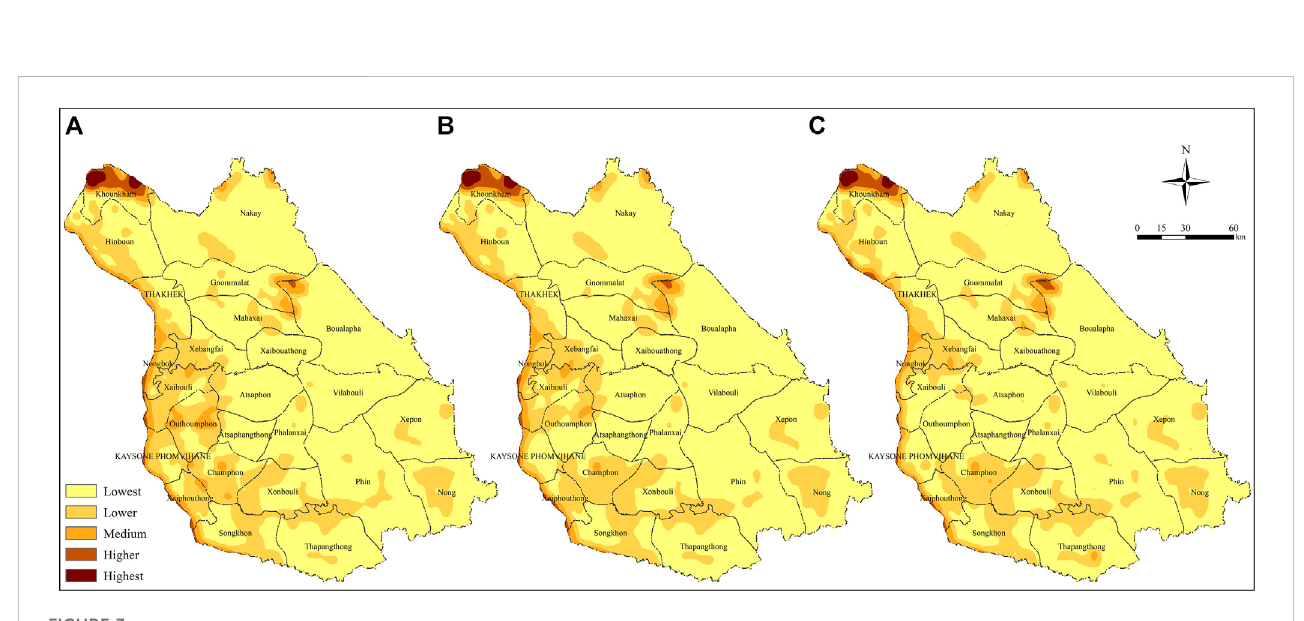
FIGURE 3 Distribution of ecological risk levels from 2000 to 2020: (A) 2000, (B) 2010; (C)